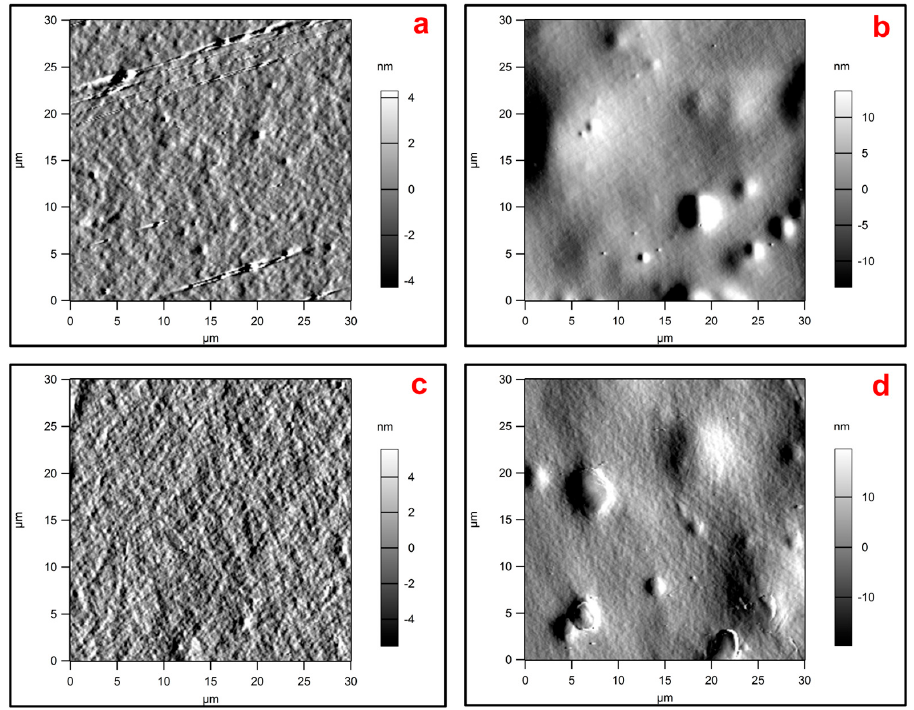
Figure 2. AFM images of films: ( a ) PLA-c; ( b ) PLA- g -TPCS; ( c ) PLA-GRH; ( d ) PLA- g -TPCS-GRH.